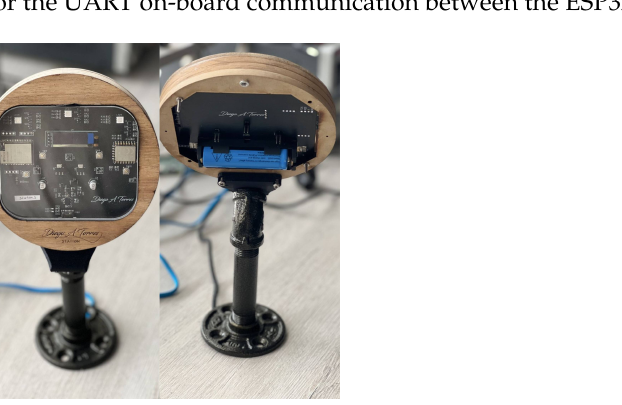
Figure 14. Final implementation of a scanning station (front and back). Taken from [24]. Table 7. WiFi and BLE communication tests of the scanning stations (taken from